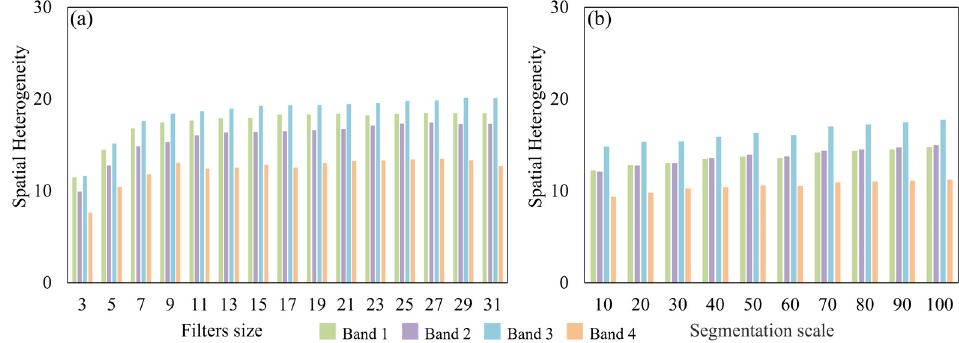
Figure 8. The results of SH using various window sizes ( a ) and segmentation scales ( b